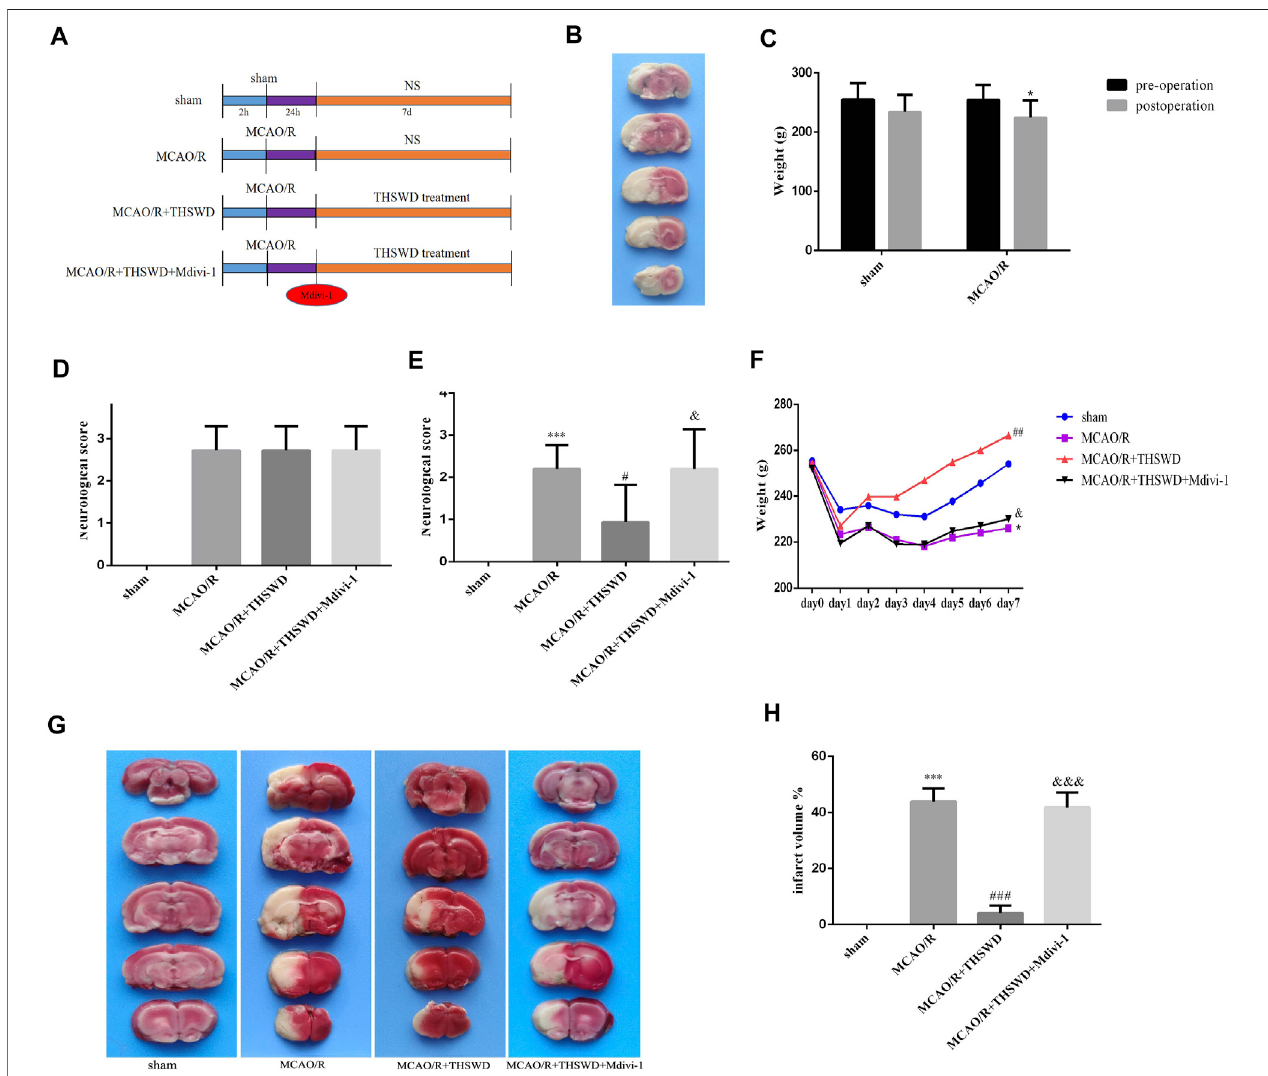
FIGURE 1 | Effects of THSWD on CIRI. (A) The fl ow diagram of the experiment. (B) Picture of brain TTC staining in MCAO/R model rat. (C) Weight change before and after MCAO/R. * p < 0.05 versus sham group (weight loss). (D) Neurological de fi cit scores before drug administration. The scores were not statistically different betweenthegroupsexceptforthesham-operatedgroup. (E) Neurologicalde fi citscoresaftertreatment. n =15pergroup. (F) Dailybodyweightofratsineachgroup. n = 15pergroup. (G) RepresentativepicturesofTTCstaining. (H) Quantitativeanalysisofcerebralinfarctvolumes; n =5pergroup. p p < 0.05versusshamgroup,*** p < 0.001 versus sham group, # p < 0.05, ## p < 0.01, ### p < 0.001 versus MCAO/R group, & p < 0.05, &&& p < 0.001 versus MCAO/R + THWSD group.